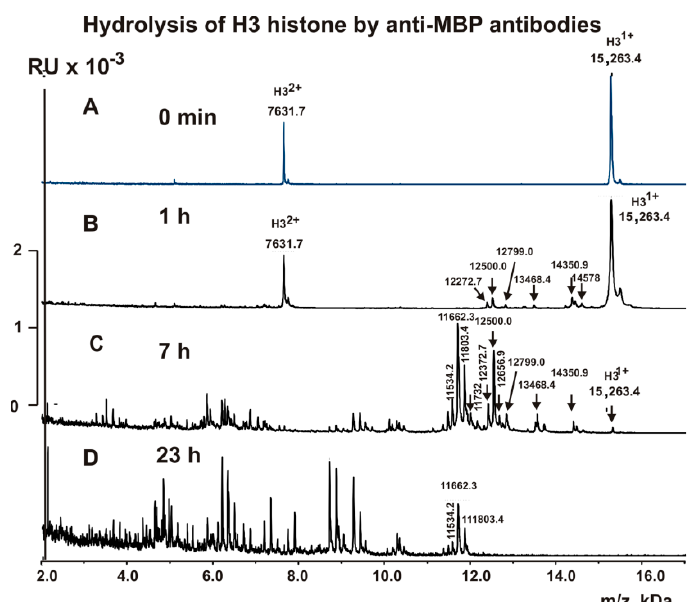
Figure 2. MALDI spectra ( A – D ) corresponding to H3 histone (1.0 mg/mL) over time hydrolysis (0–23 h) by anti-MBP IgGs (5.0 µg/mL).